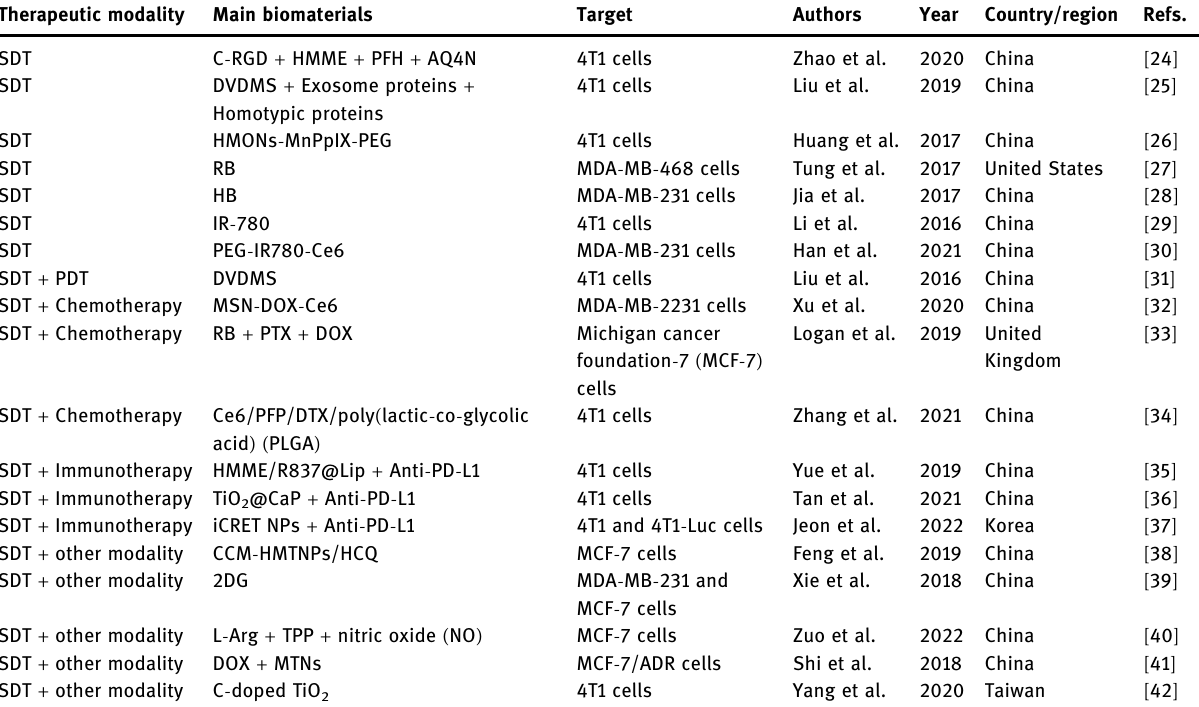
Table 1: Summary of SDT - based therapies for BC Therapeutic